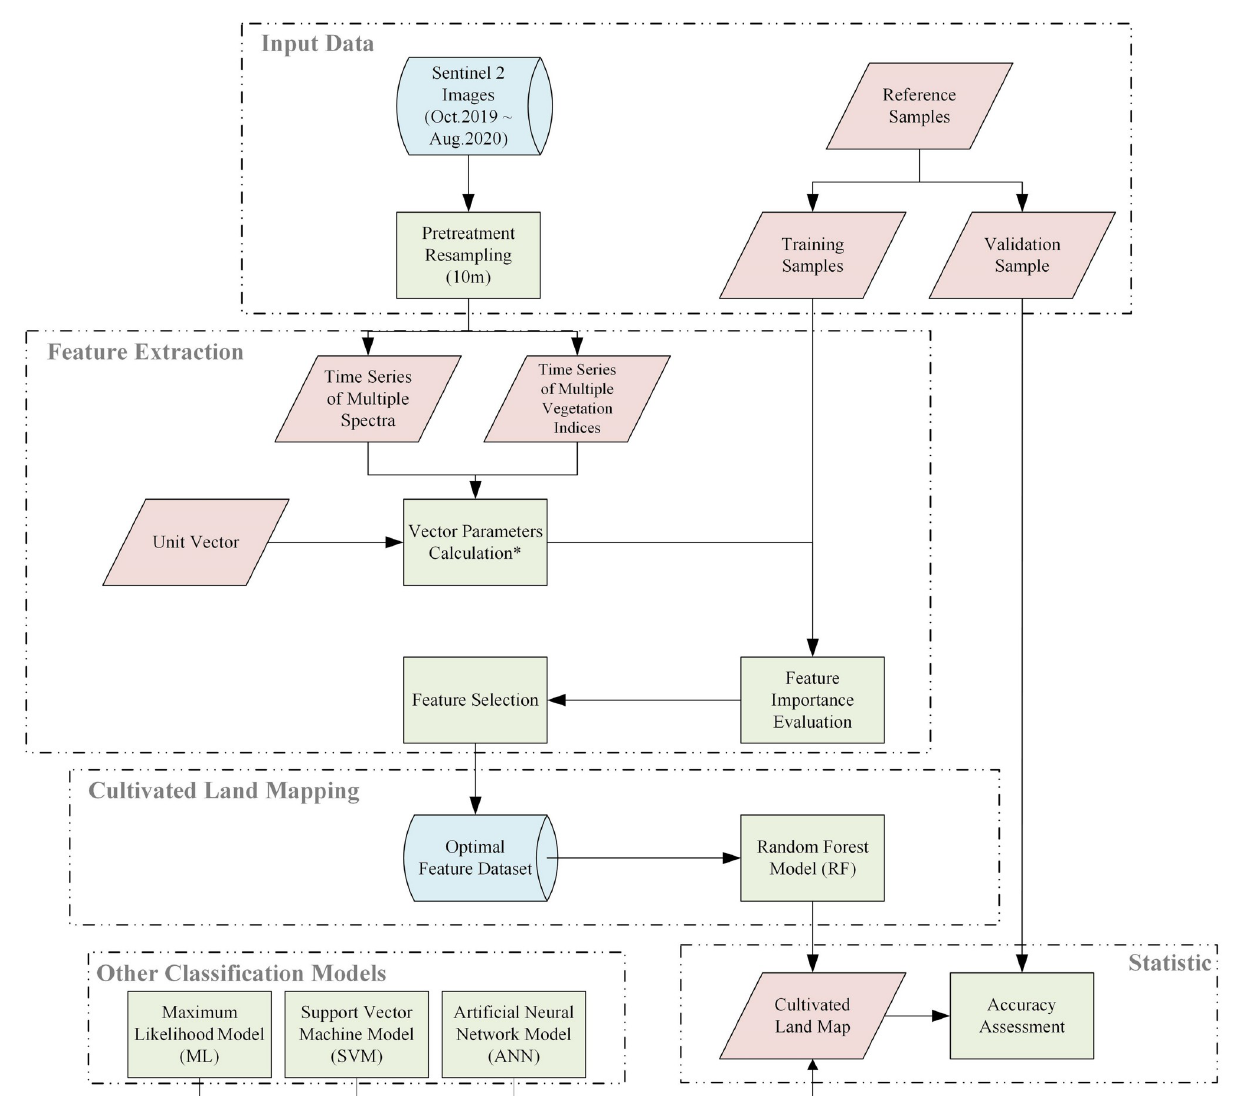
Fig 3. Work flow of the proposed method (the vector parameters included Cos, Dis, Max, Min, and